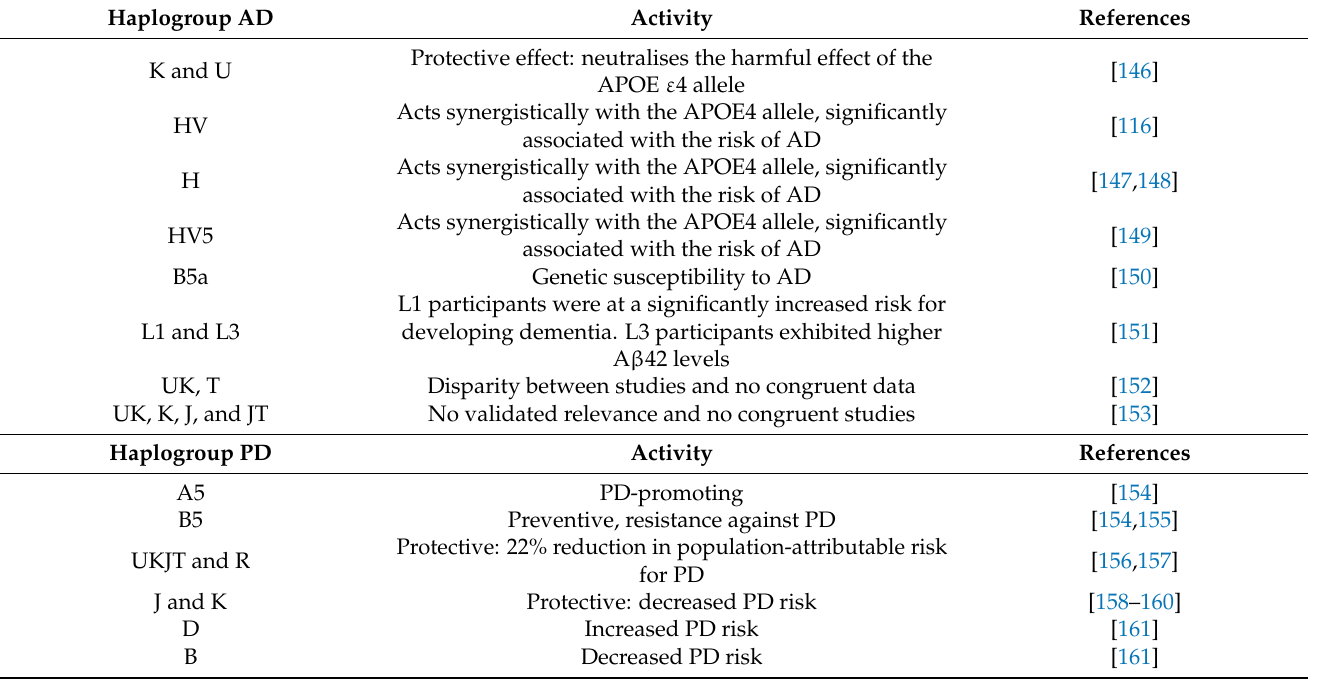
Table 2. Haplogroups identified for AD and